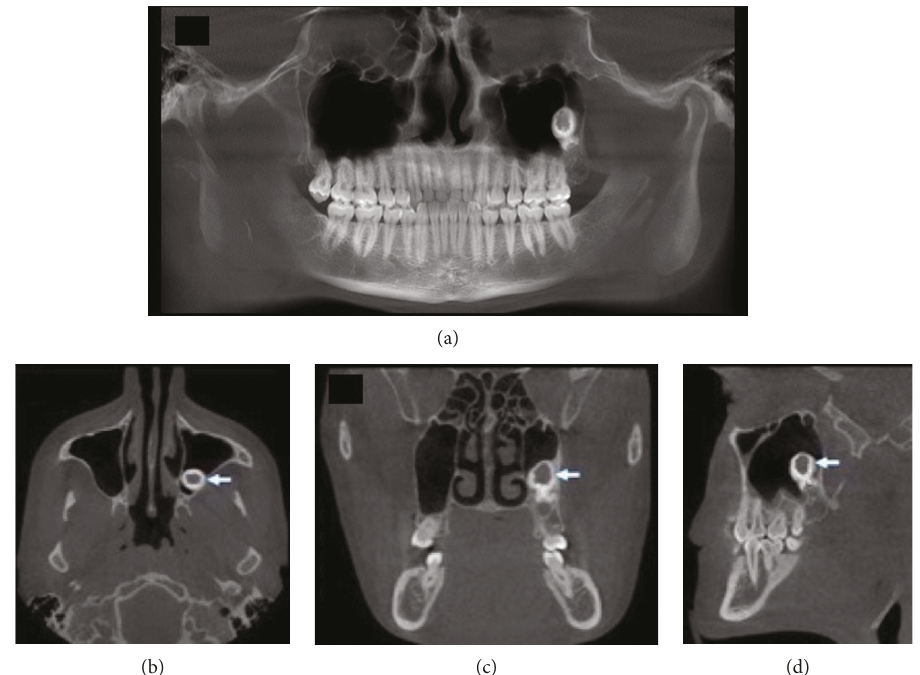
Figure 1: Computed tomography preoperative showing mass associated with the roots of the third molar inside the maxillary sinus. (a) Panoramic view. (b) Axial plane. (c) Coronal plane. (d) Sagittal